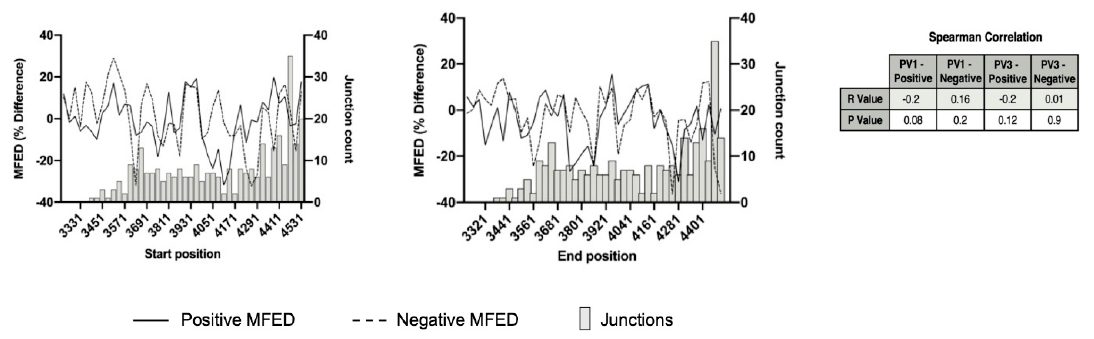
Figure 5. The influence of identical sequence length and reading frame on imprecise recombination. ( A ) The imprecise recombinants were counted at each identical length ( x -axis) and the percentage proportion related to the total imprecise junctions was calculated ( y -axis). The flattened data of the Figure 6. The influence of RNA structure on recombination. The MFED was calculated for a 100 nt imprecise recombinants generated from the coinfection experiments (grey) were plotted against a sliding window (at 30 nt increments) for both PV1 and PV3 positive and negative strands (dashed random control (black), where every possible imprecise junction was created and classified using a and solid lines, respectively) and plotted against the number of total recombinants within the same custom Perl script. ( B ) In the upper panel, the locations of the detected imprecise recombinants on sliding window. We chose a 100 nt window, as we found from our previous studies [19,20,28] that the PV1 genome were plotted against the NGS read count. In the lower panel, the size of either the decreasing the sliding window size would introduce noise to the system attributed to the appear- insertions or deletions of the detected recombinants were plotted against NGS read count. Each dot ance and disappearance of small stem–loop structures, making the MFED values less conclusive. represents a unique recombinant. Spearman’s correlation coefficient was calculated between the recombinant count and the MFED values on either strand.